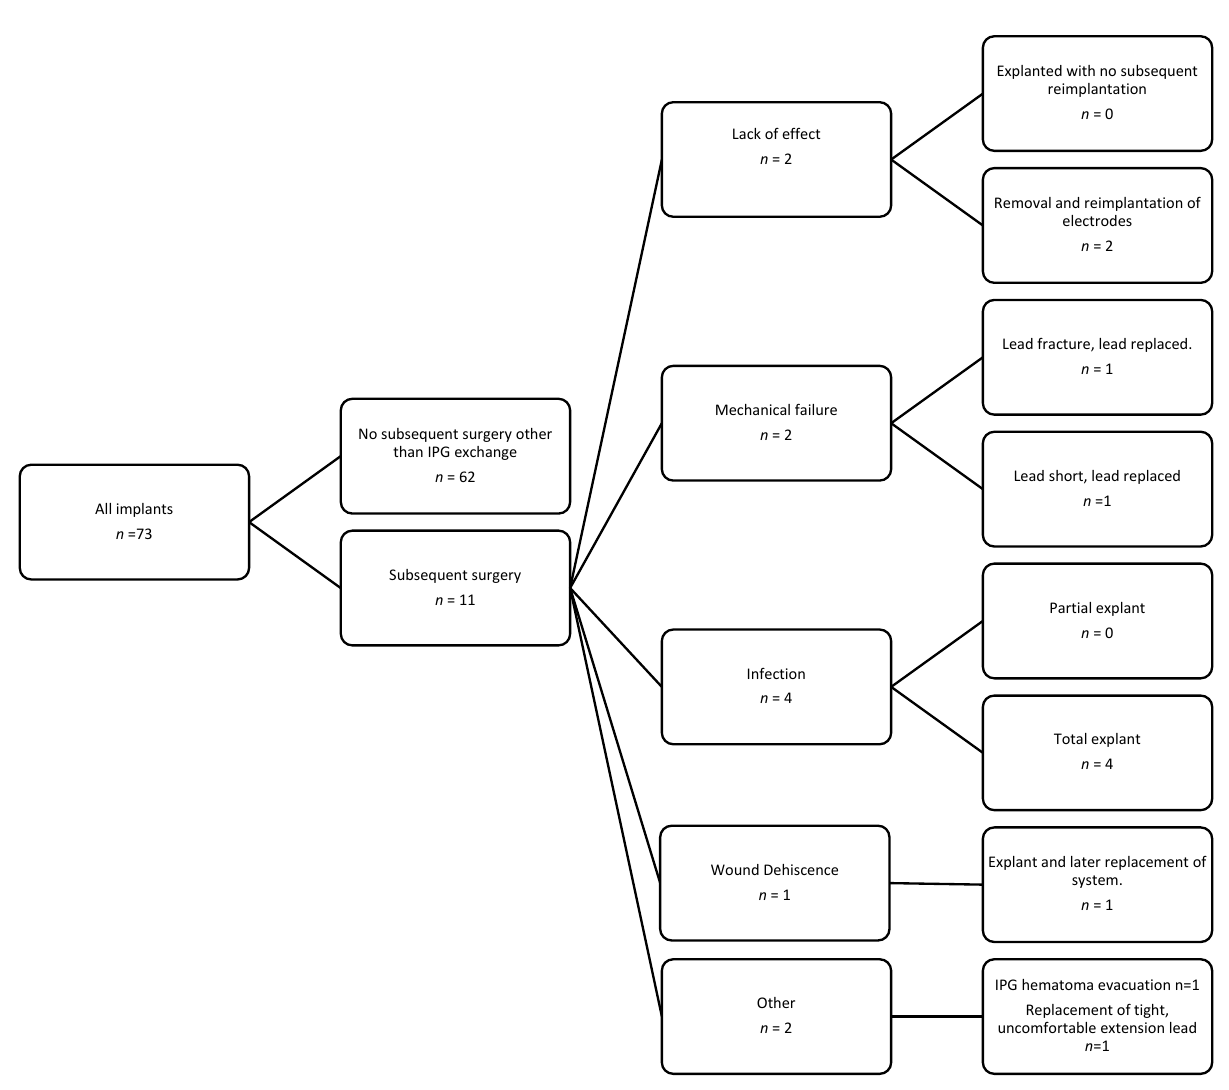
Figure 3. Flow chart of outcomes.